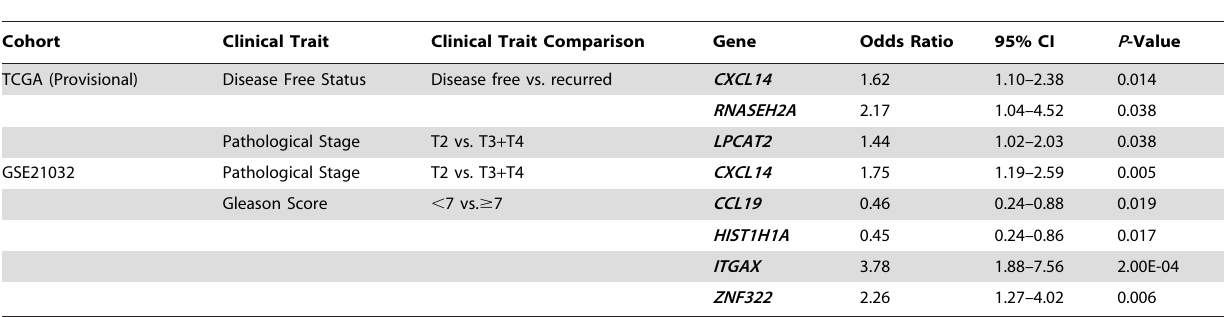
Table 3. Stepwise logistic regression analysis of QTL candidate genes in TCGA (Provisional) and GSE21032 cohorts.